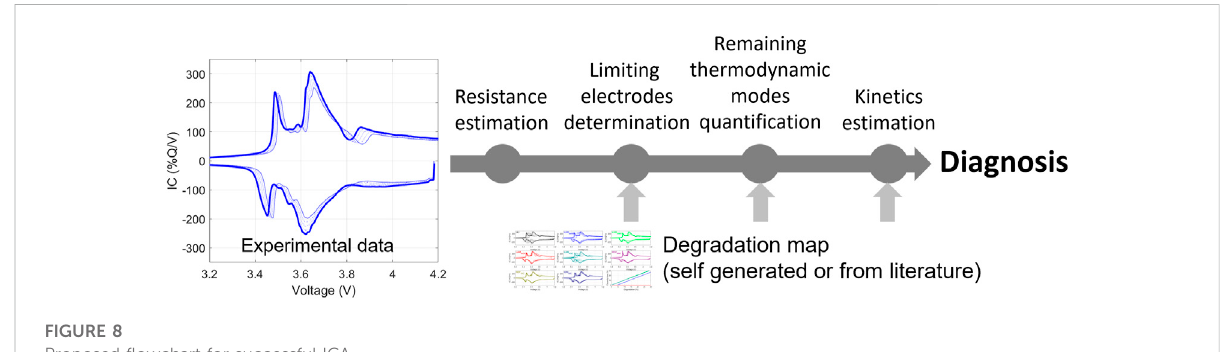
FIGURE 8 Proposed fl owchart for successful